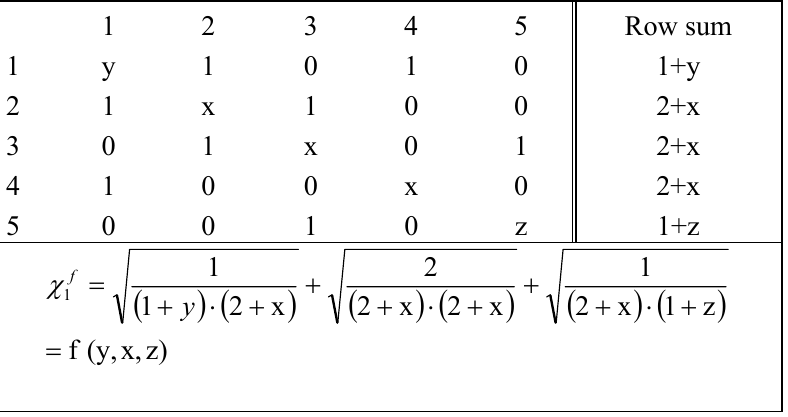
Table 2. Augmented adjacency matrix for the hypothetical compound YX